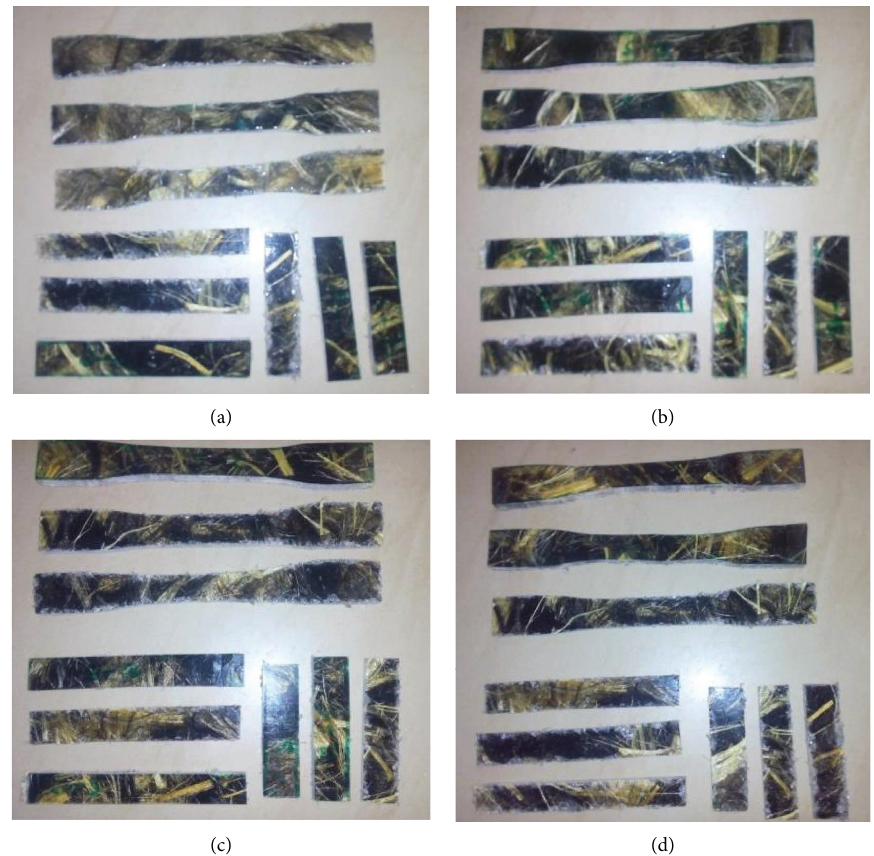
Figure 1: Test specimens for mechanical properties as per ASTM standards. (a) Composite A. (b) Composite B. (c) Composite C. (d) Composite Table 2: Machining parameters and its levels. Parameters/level